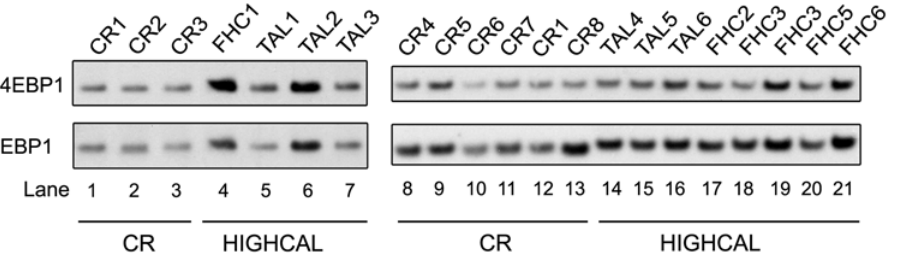
Figure 2. CR-induced phosphorylation changes in Eif4ebp1. Western blots of unphosphorylated Eif4ebp1 (4EBP1) and Thr69 phosphorylated Eif4ebp1 (p4EBP1) for calorie restricted (CR) and high-calorie-fed (HIGHCAL) mice. Labels at top indicate individual mouse sample codes. CR, Calorie Restriction; FHC, Fixed High Calorie feeding; TAL, True Ad Libitum feeding. TAL1, TAL3, and TAL4 are from livers used to make the RNA pool TAL-P. CR1, CR7, and CR8 are from livers used to make the RNA pool CR-P1. CR4, CR5, and CR6 are from livers used to make the RNA pool CR-P2. FHC3 and FHC3B are separate samplings of the same liver.